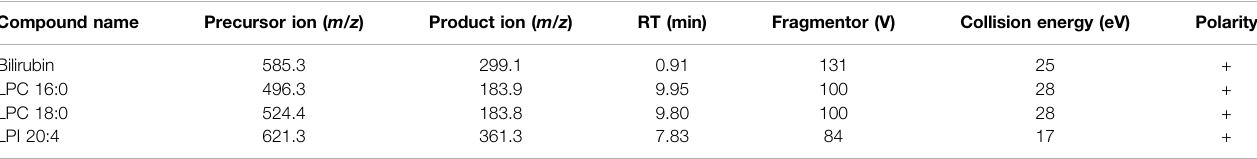
TABLE 1| Optimized MStransitionsand parameters forthe targeted analysis. LPC:Lysophosphatidylcholine, LPI: Lysophosphatidylinositol,RT:Retentiontime, V:Volt,eV: Electronvolt. Compound